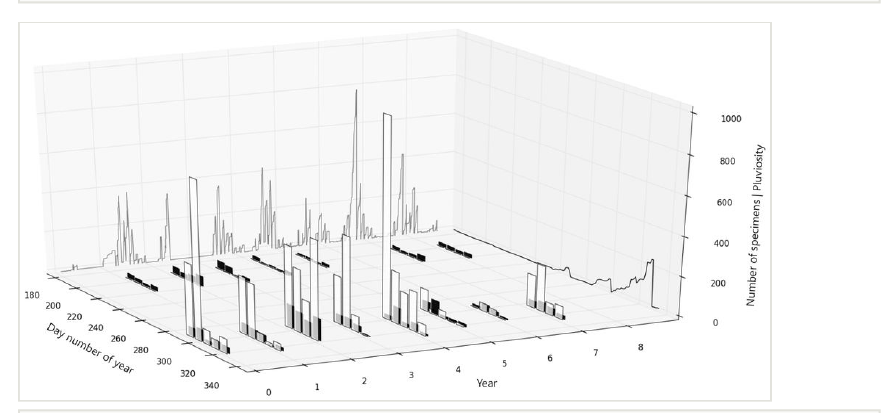
Total number of specimens collected in each sampling week (=each black & white bar pair, equivalent to 3 areas x 3 traps) for T. polita (white, fi rst plane) vs. other Cryptinae (black, behind), along the sampled seasons (Day number of year, where DS=183–215, RS=286–322), discriminated for each year (0–1 = 2000–2008). Left wall (YZ axes) shows daily records of precipitation (cumulative values within each month), for all years (2893 records total); right wall (YX axes) shows average of precipitation for each Day number of year (each day = average of all years). Scale for number of specimens and precipitation (Y-axis) are